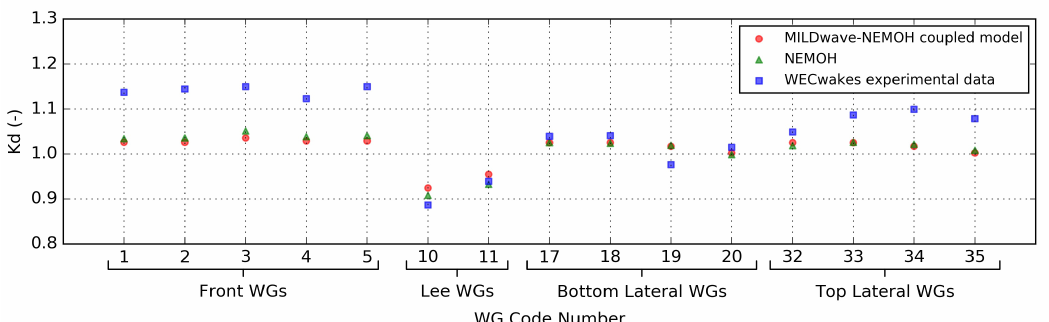
Figure 7. Comparison of the K d between the MILDwave-NEMOH coupled model and the WECwakes experimental data for all 15 WGs of Figure 1A for Test Case 6 of Table 1.